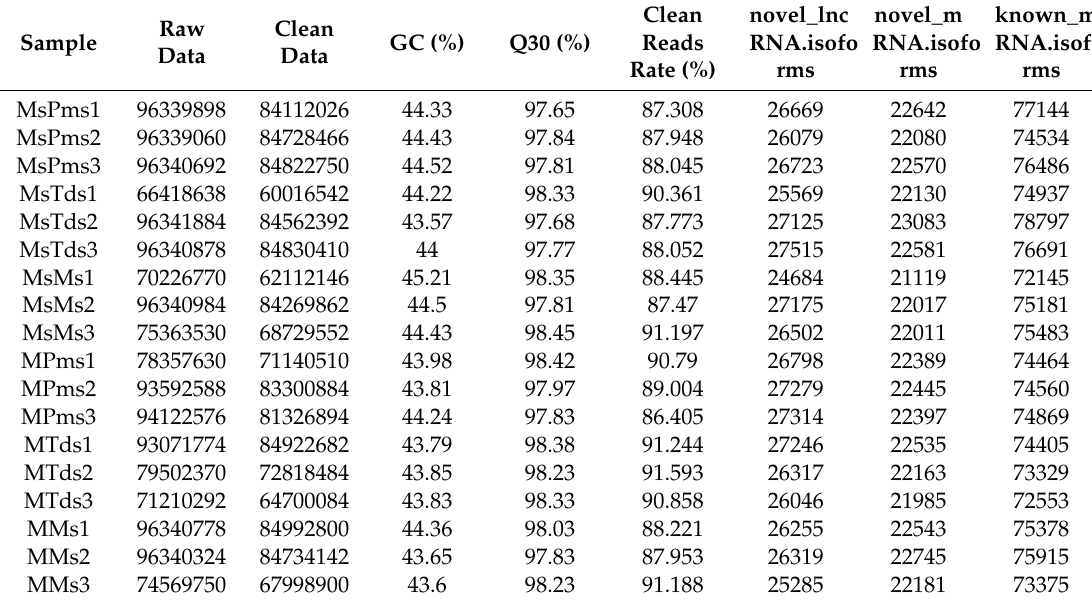
Table 1. Summary of tag numbers.